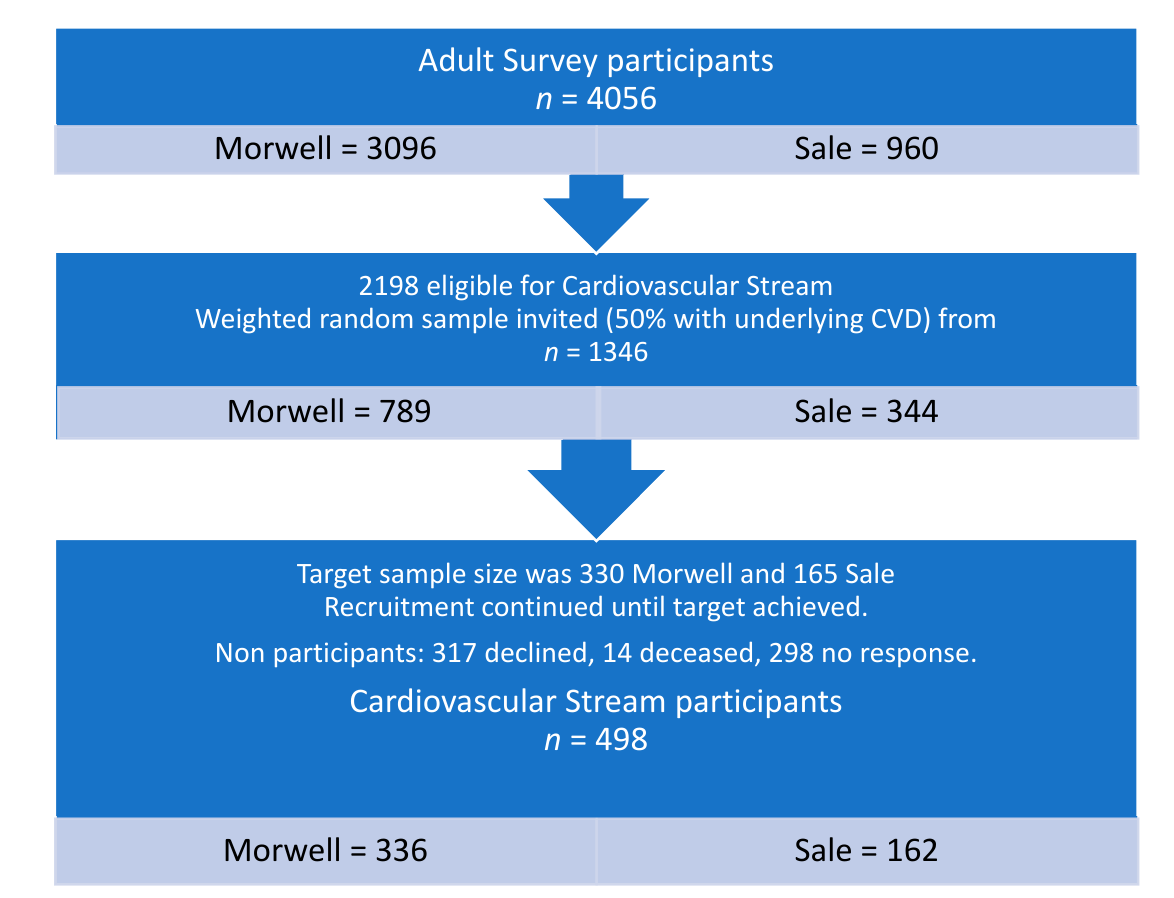
Figure 1. Flow diagram of participant recruitment. Table 1. Demographic and social characteristics of exposed and unexposed